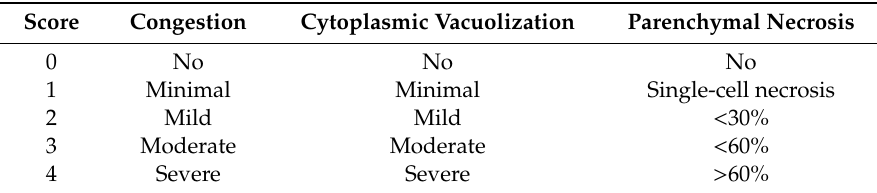
Table 3. Suzuki scoring